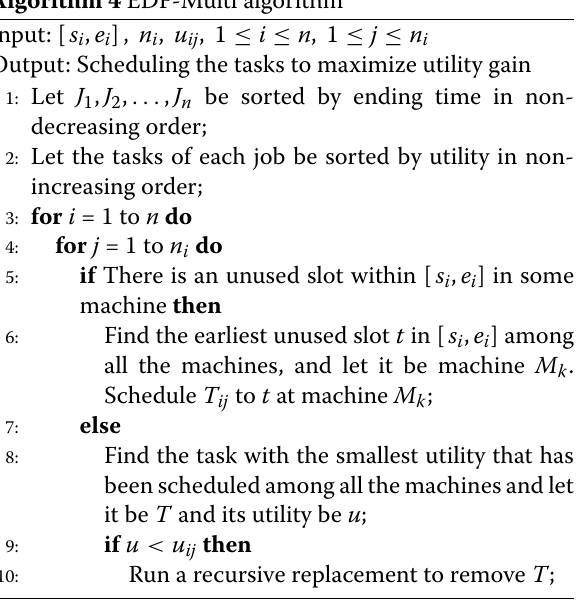
Algorithm 4. The obtained result is optimal for the prob- lem without extra utility.